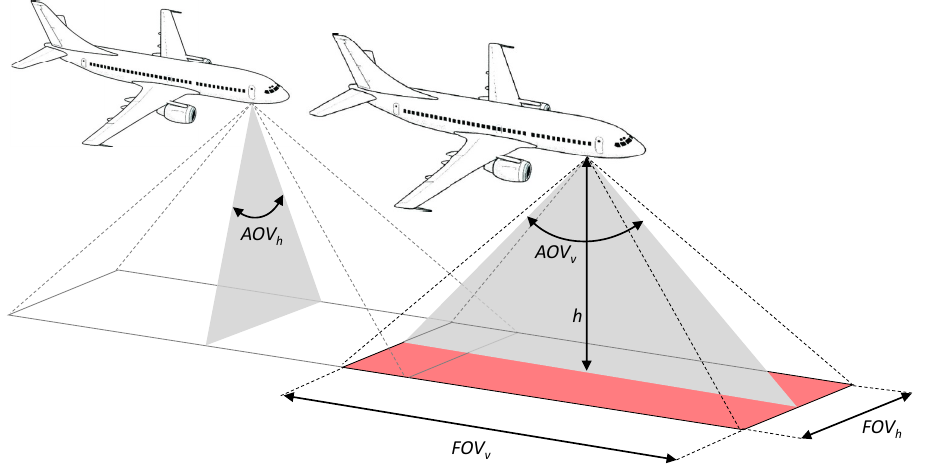
Figure 2. Field of view ( FOV ) in relation to the angle of view ( AOV ) and aircraft altitude h . Polygons were created for each flight separately, where each polygon represented the FOV of a single aircraft during its flight. For instance, three polygons are depicted in Figure 3 representing three flights, i.e., three aircraft taking off from Rome Fiumicino Airport. Their FOV was very narrow during take-off, while it became broader as the aircraft gained altitude. Additionally, Figure 3 shows three different polygons for each flight representing three different cameras from Table 3. Canon A2400 had the smallest coverage depicted in red, while Sony A7 and Imperex T9040 covered additional areas depicted in yellow and blue, respectively.